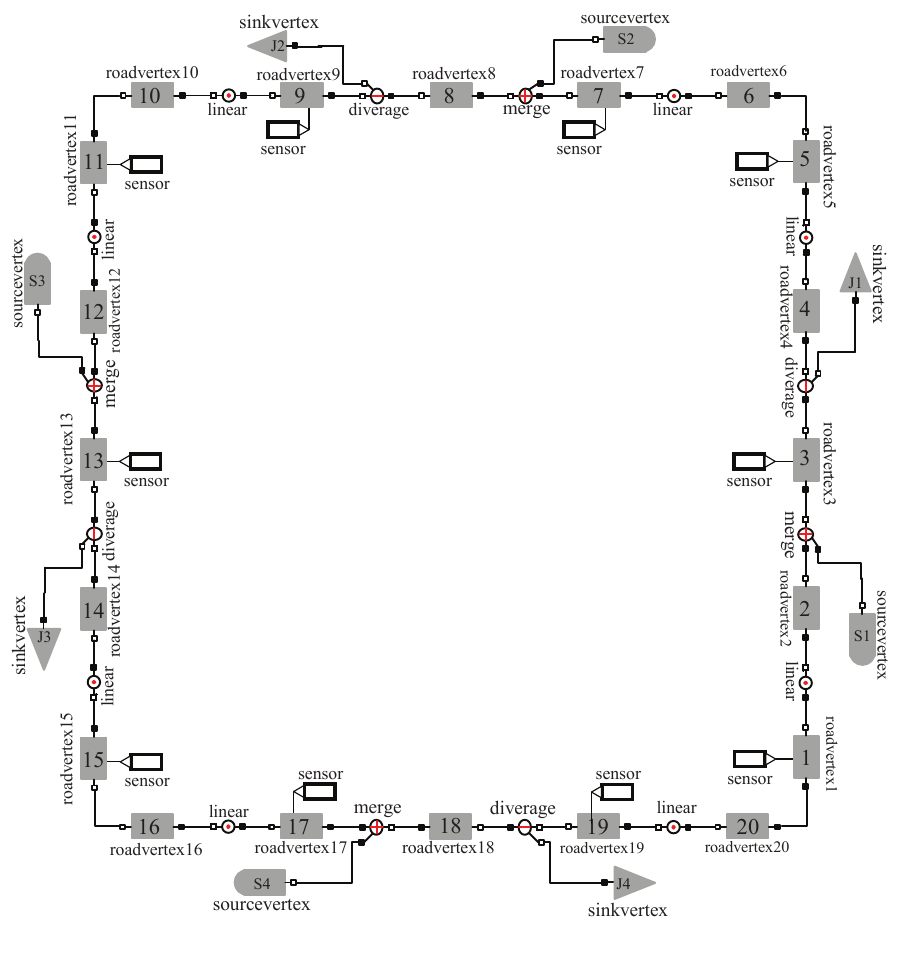
Figure 7. The simplified version of Beijing third ring freeway. Table 2. Cell length of simplified third ring freeway.